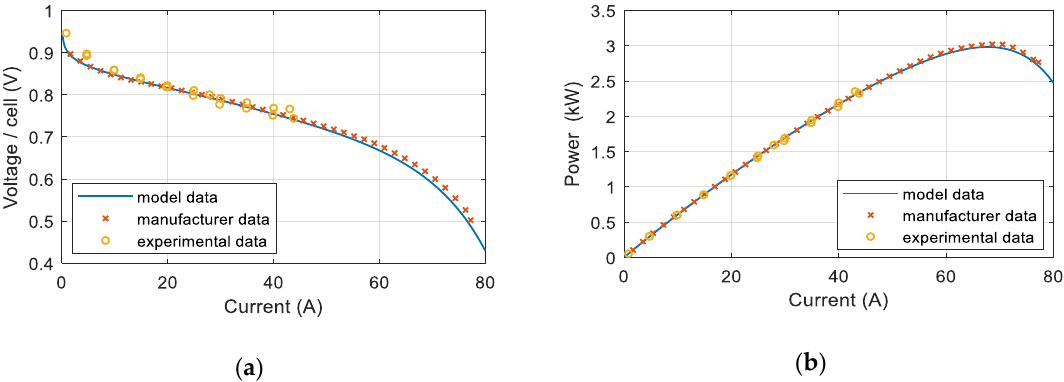
Figure A1. Experimental verification of the models a: ( a ) 2000 Ah lead acid battery ( b ) Electrolyzer.